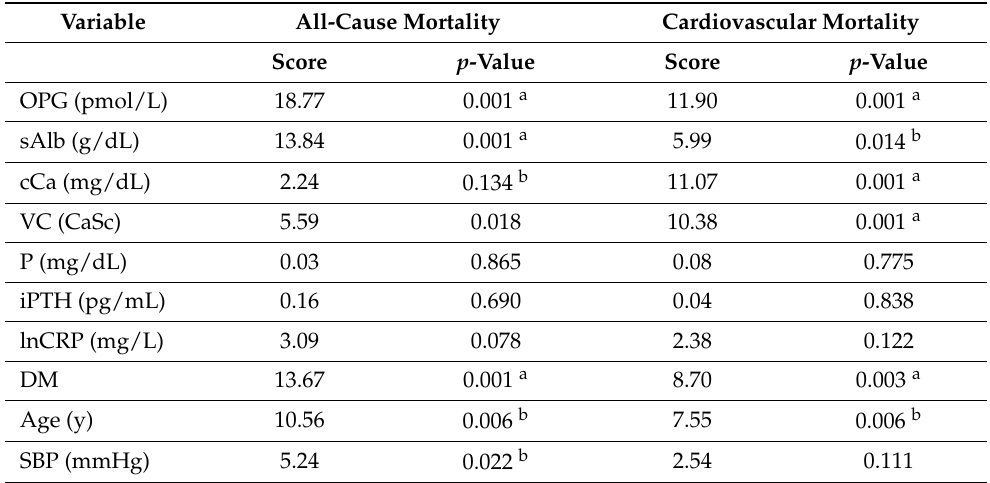
Table 6. Scores of variables associated with all-cause and cardiovascular mortality in incident peritoneal dialysis